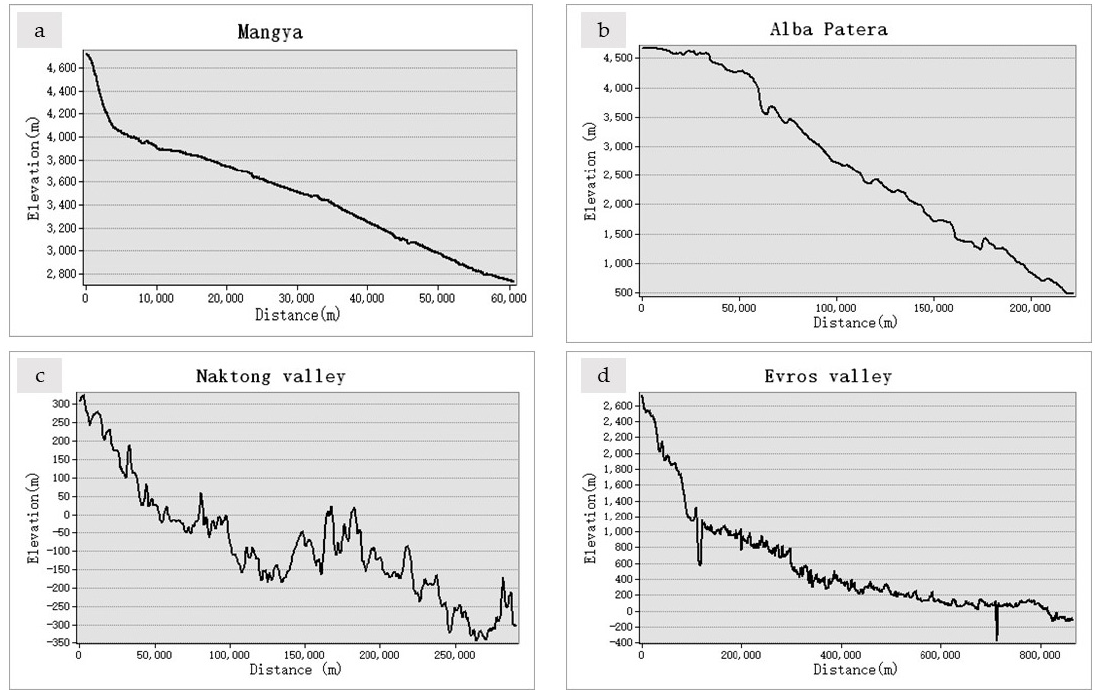
Figure 5. The river longitudinal profiles of the representative streams on Mars and the Qaidam Basin. ( a ) is the longitudinal profile of the river on the Qaidam Basin. ( b – d ) represents the Amazonian, Hesperian, and Noachian valley networks on Mars, respectively.